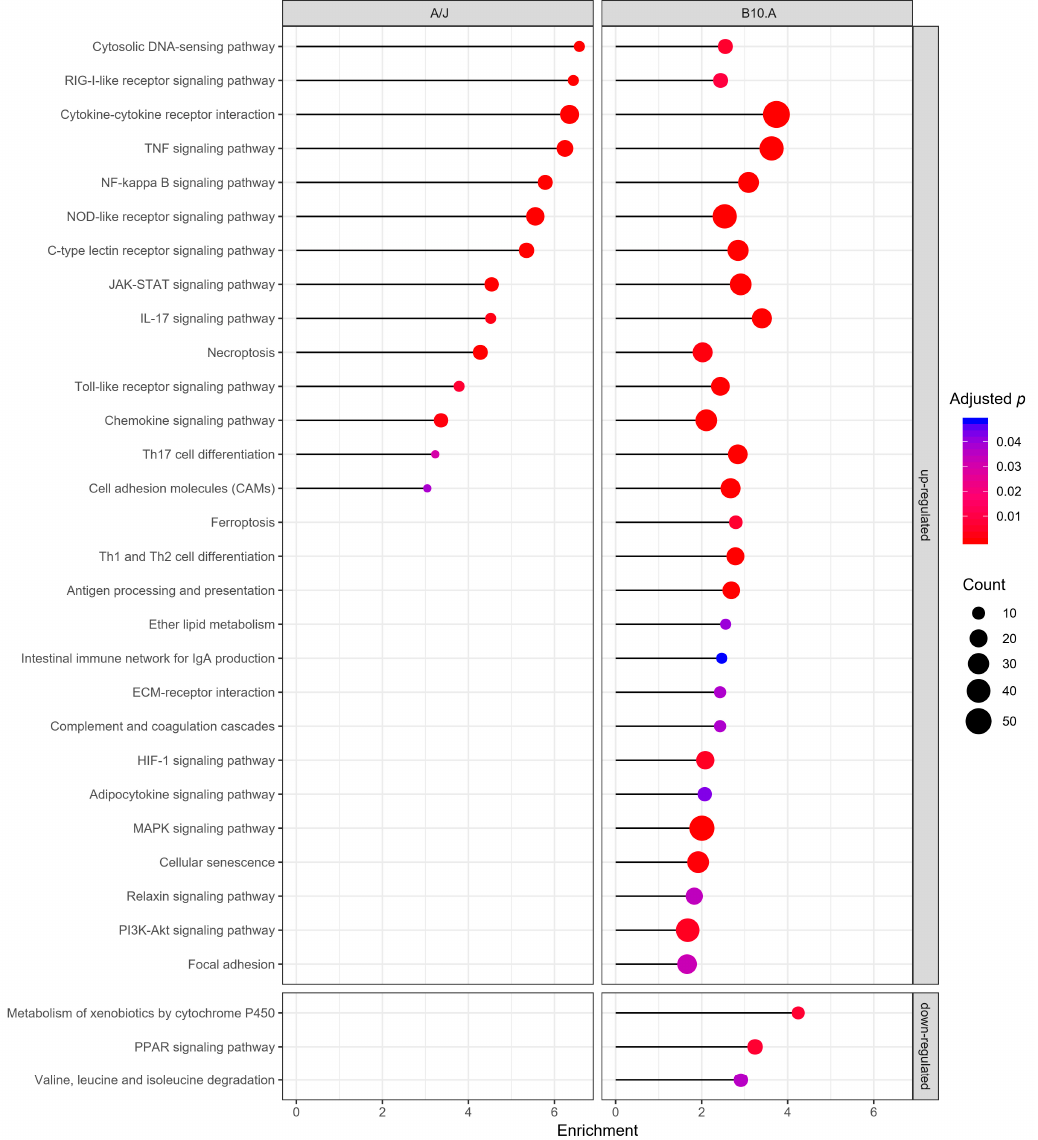
Figure 5. Kegg pathway enrichment of differentially expressed genes in BMDCs derived 355 Figure 5. Kyoto Encyclopedia of Genes and Genomes (KEGG) pathway enrichment of di ff erentially from resistant (A/J) and susceptible (B10.A) mouse strains in response to P. brasiliensis 356 expressed genes in BMDCs derived from resistant (A / J) and susceptible (B10.A) mouse strains in response to P. brasiliensis infection. Enriched pathways (adjusted p -value < 0.05) associated with infection. Enriched pathways (adjusted p -value < 0.05) associated to DEG up-regulated or 357 upregulated or downregulated DEG for the two murine strains. The x -axis represents the enrichment down-regulated for the two murine strains. The x-axis represents the enrichment in each Pathway. 358 in each pathway. Dot size represents the number of genes in each Dot size is representative of the number of genes in each pathway. 359 360